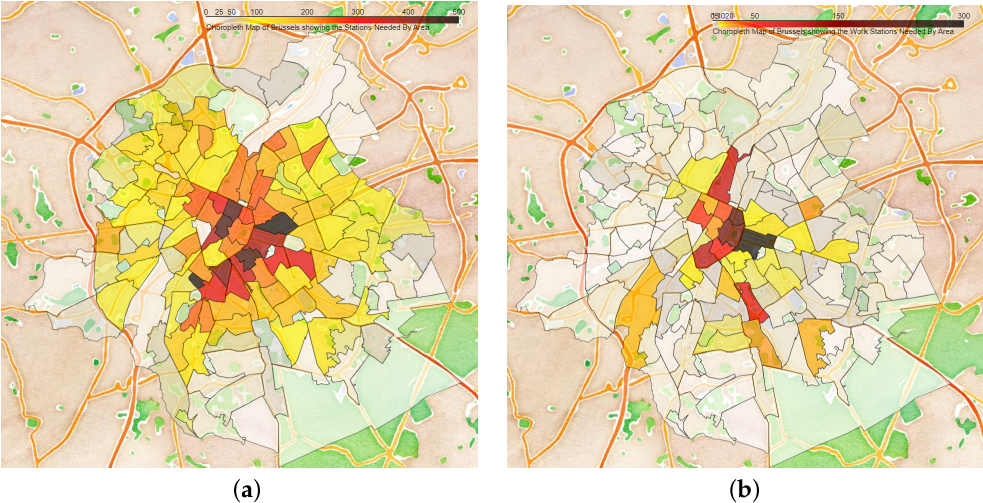
Figure 9. Number of charging stations needed for normal technology (residential vs. office charging). The number of stations are normalized by the neighborhood’s area to facilitate data interpretation and visualization. (Units: number of stations/km 2 ). ( a ) Number of normal (residential) charging stations needed in Brussels normalized by each neighborhood’s area. ( b ) Number of normal at-office charging stations needed in Brussels normalized by each neighborhood’s area.